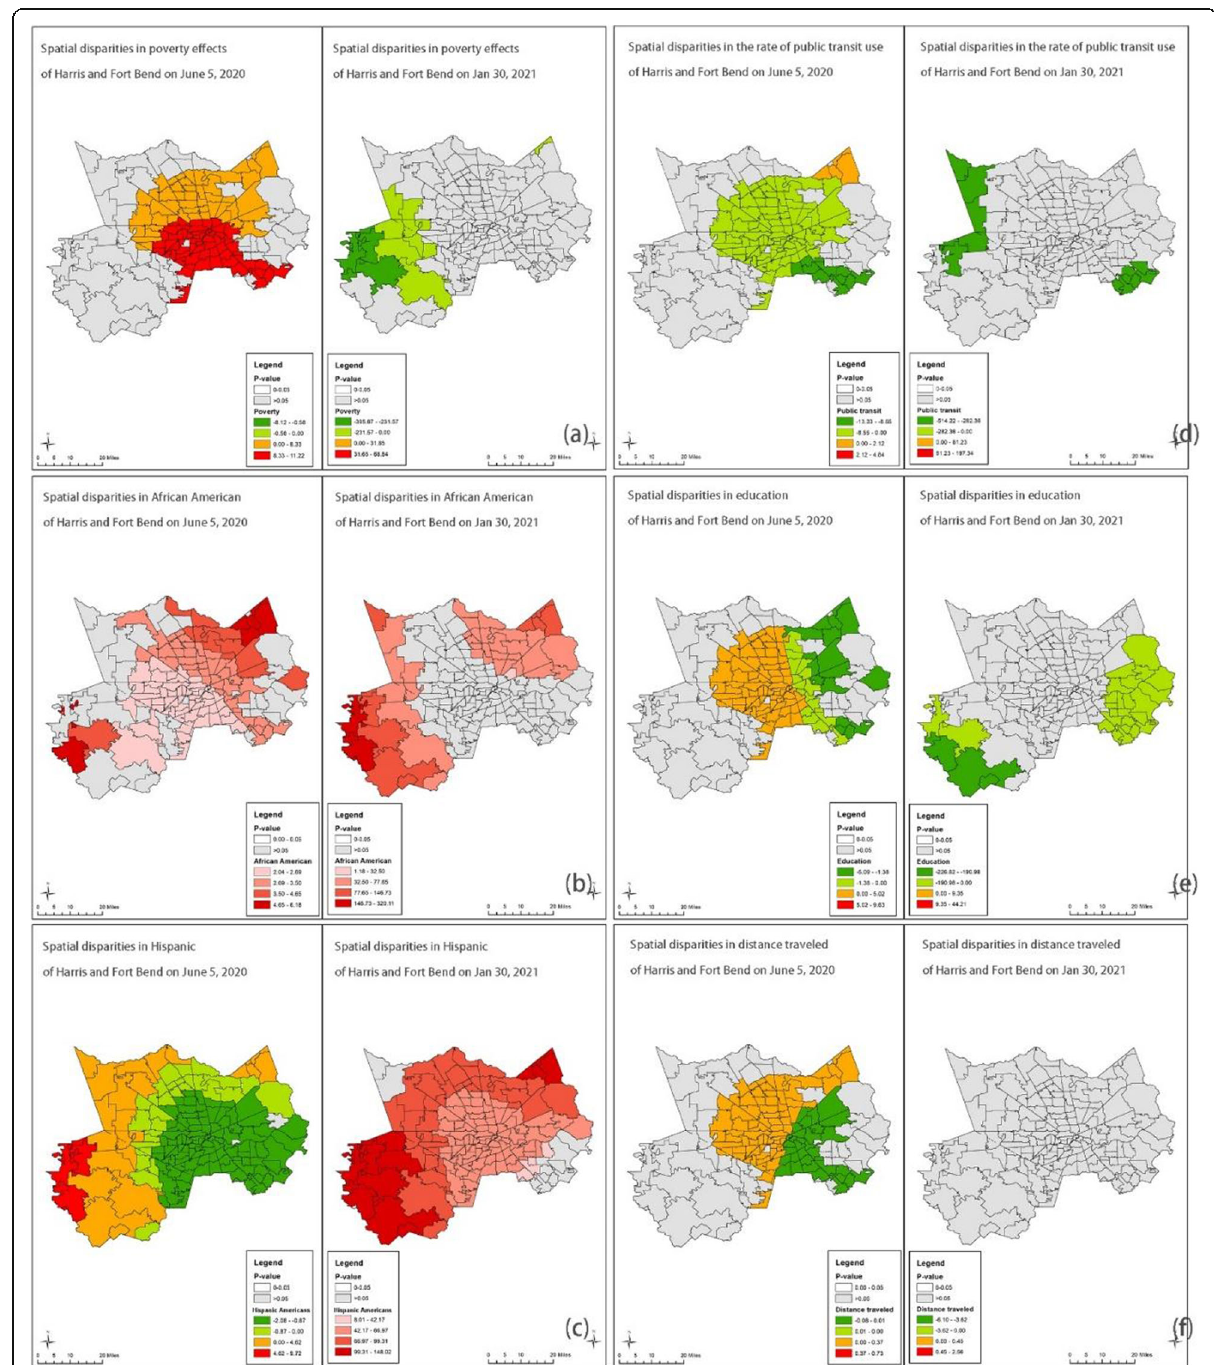
Fig. 3 GWR results for Harris and Fort Bend Counties (Average R-square = 0.20 and 0.21) Note: Early-stage data is taken on June 5, 2020, and post peak is taken on Jan 30,